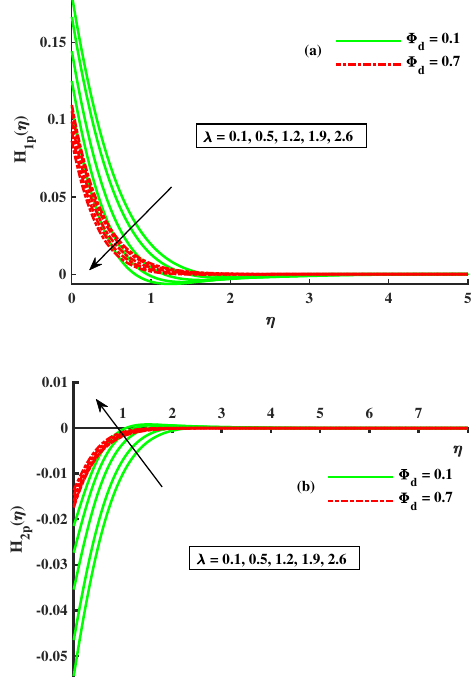
Figure 8. Influence of λ and φ d on ( a ) H 1 p ( η ) & ( b ) H 2 p ( η ) .